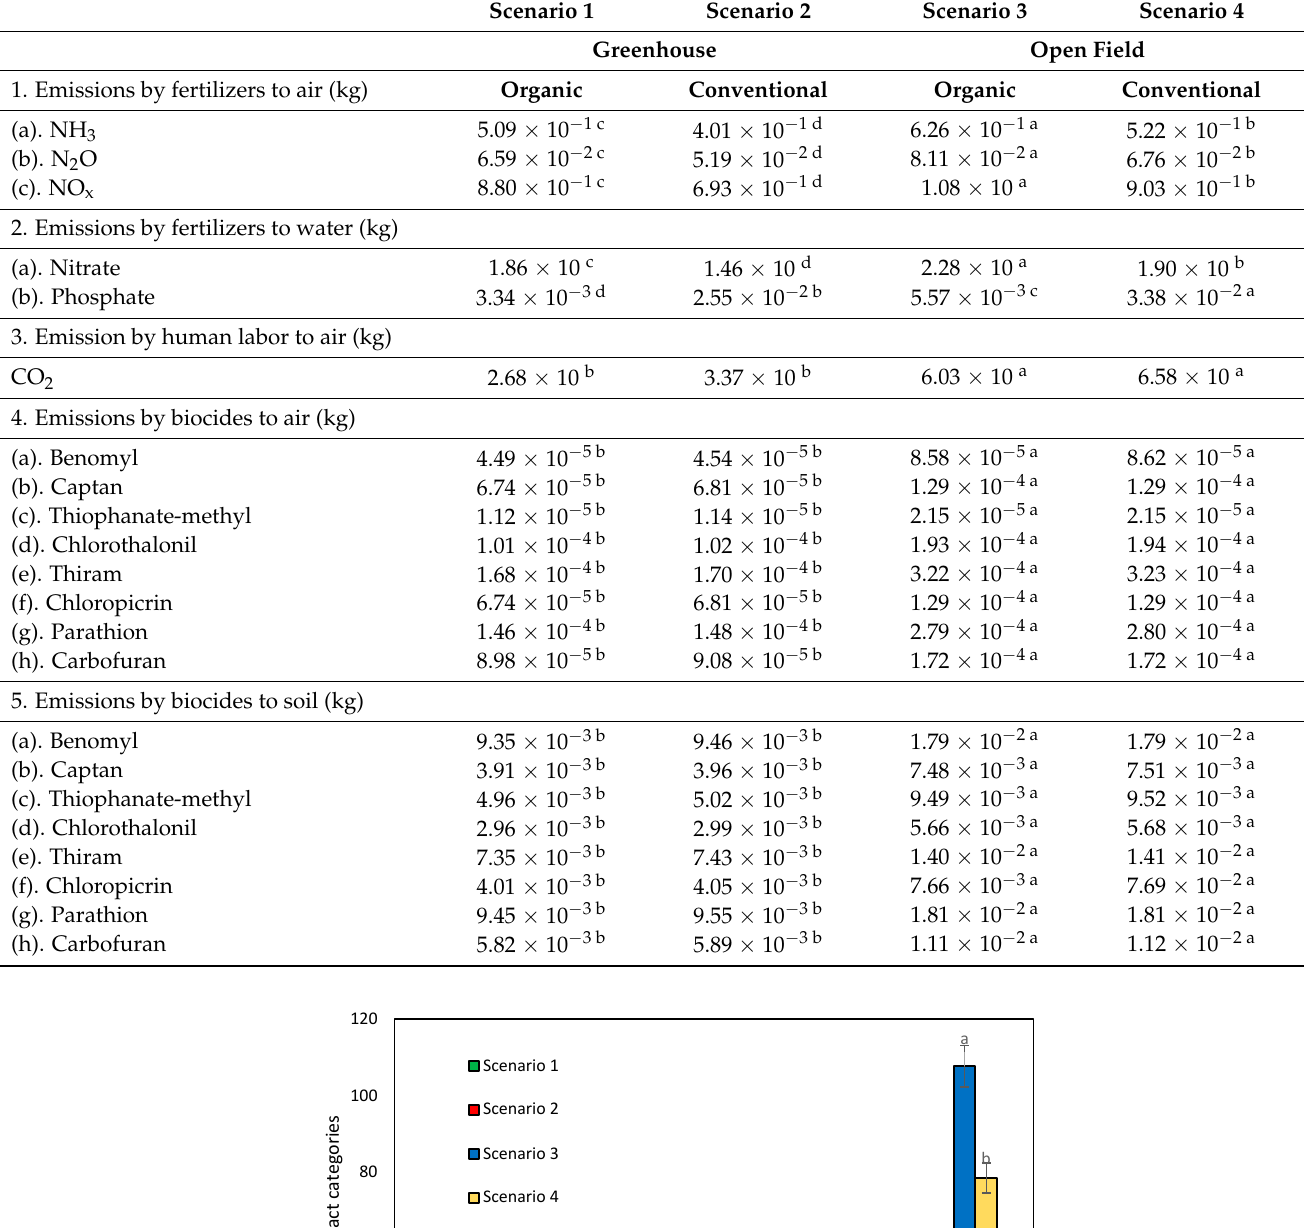
Table 6. Emissions by fertilizers, human labor, and biocides to air, water, and soil (kg) in different scenarios. Different lower cases indicate significant differences.